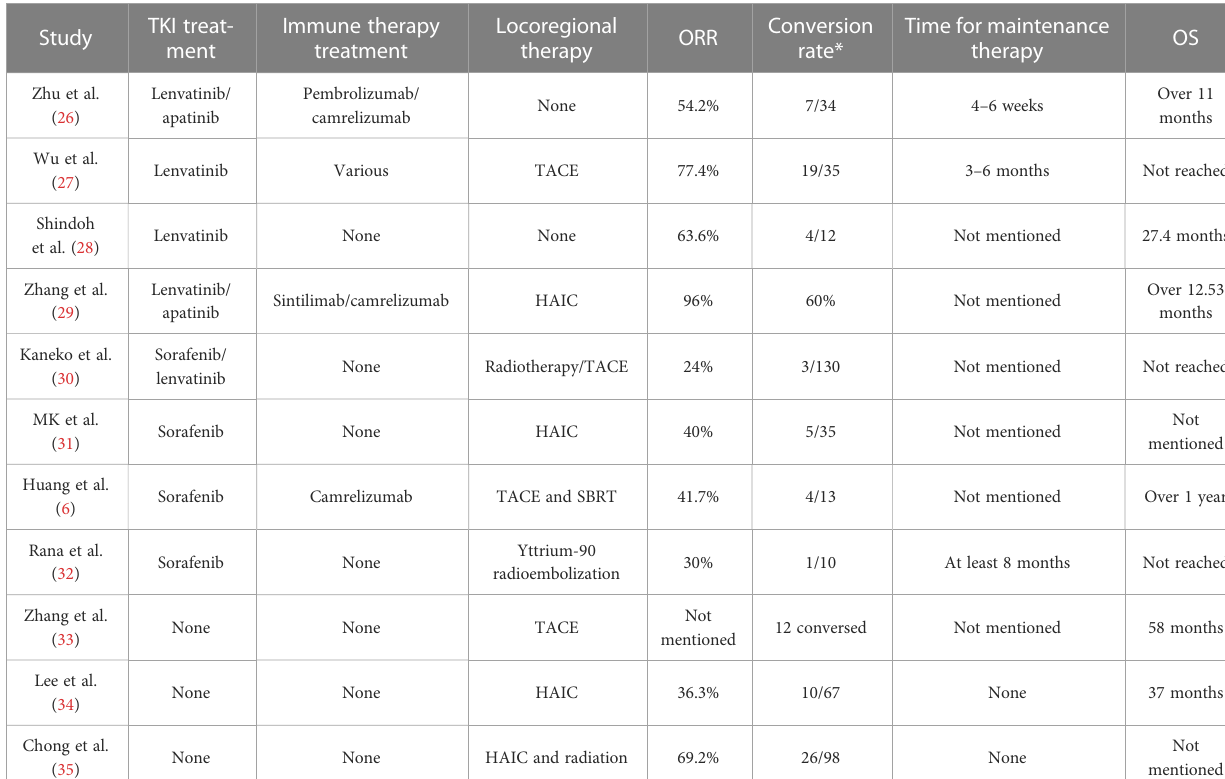
TABLE 1 Recent clinical trials concentrated on conversion